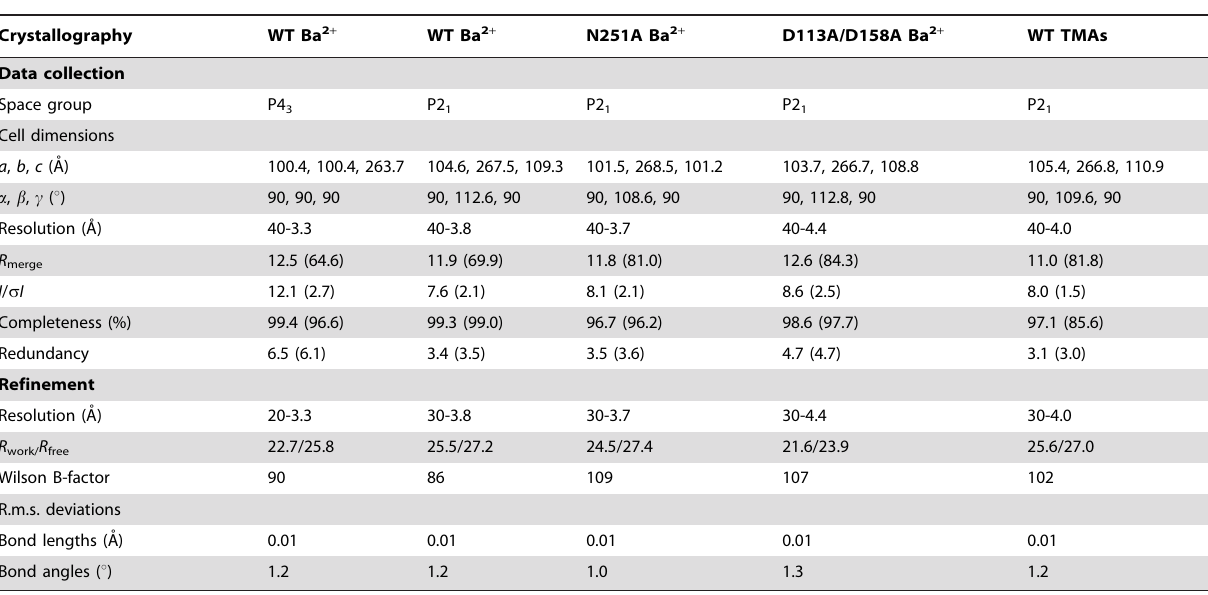
Table 3. Data collection and refinement